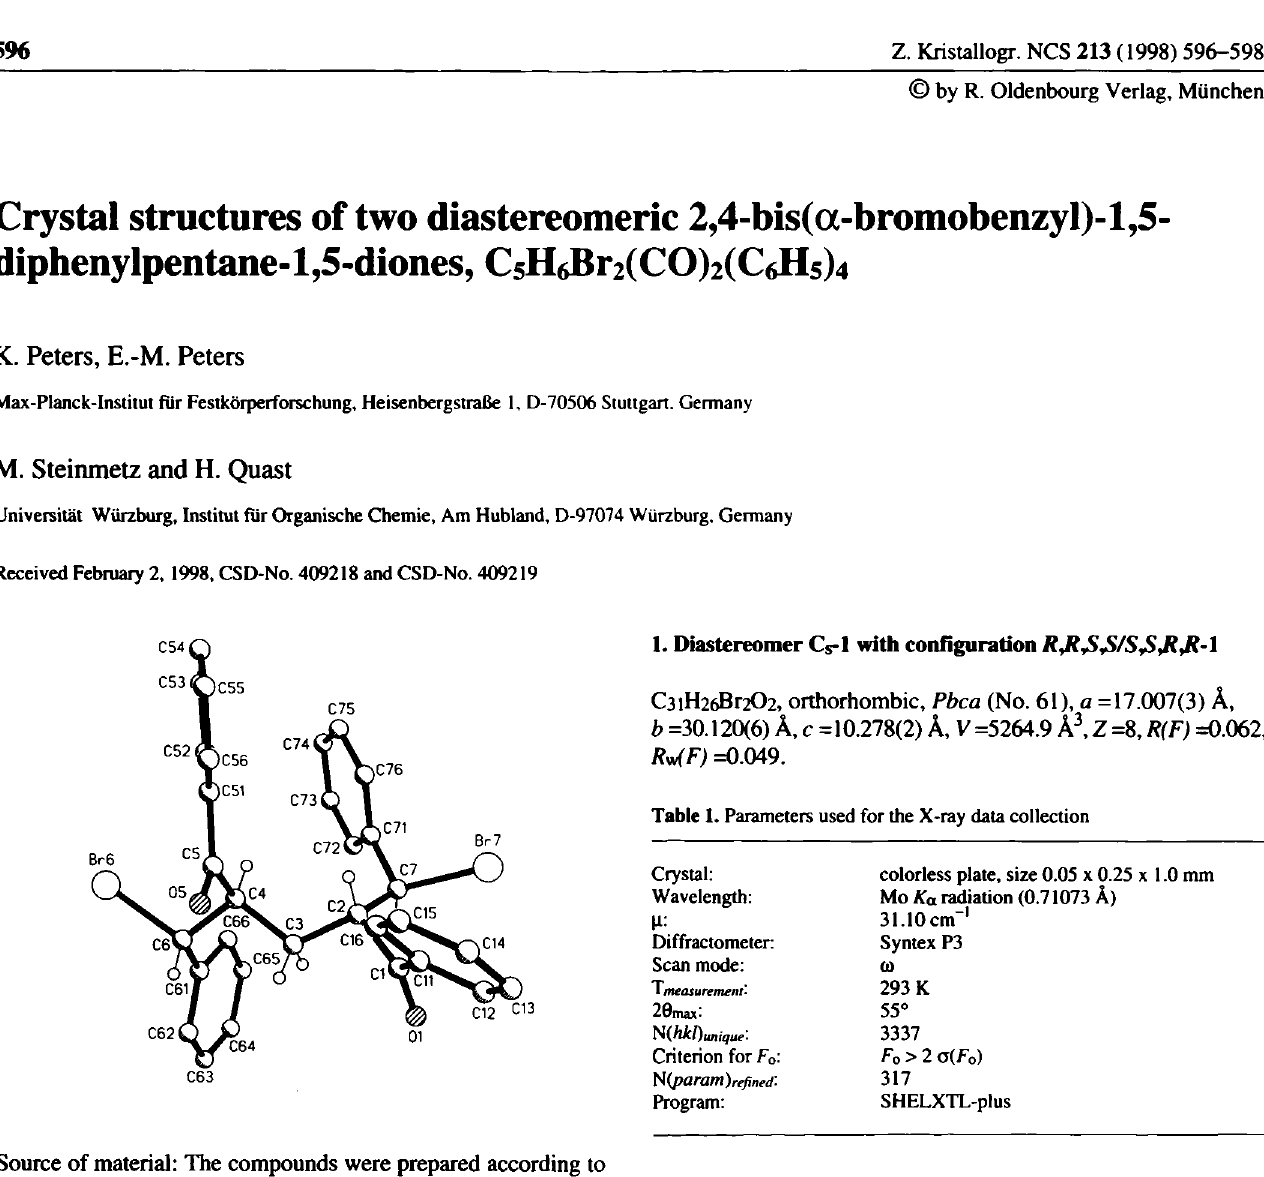
Table 2. Final atomic coordinates and displacement parameters (in